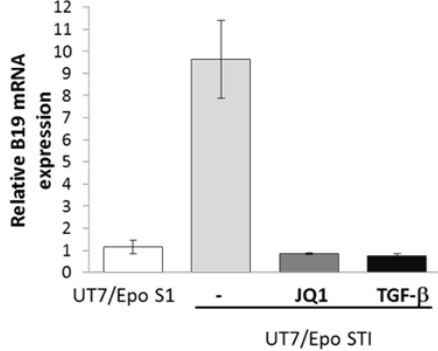
Figure 3. B19V-sensitivity of UT7/Epo-STI cells is linked to maturation stage. UT7/Epo-STI cells were cultured for 48 h before inoculation with B19V, without (-) or with JQ1 (0.5 µM) or TGF- β (2 ng/mL). 72 h post-inoculation, relative levels of B19V VP-2 mRNA were evaluated with UT7/Epo-S1 cells as the reference.